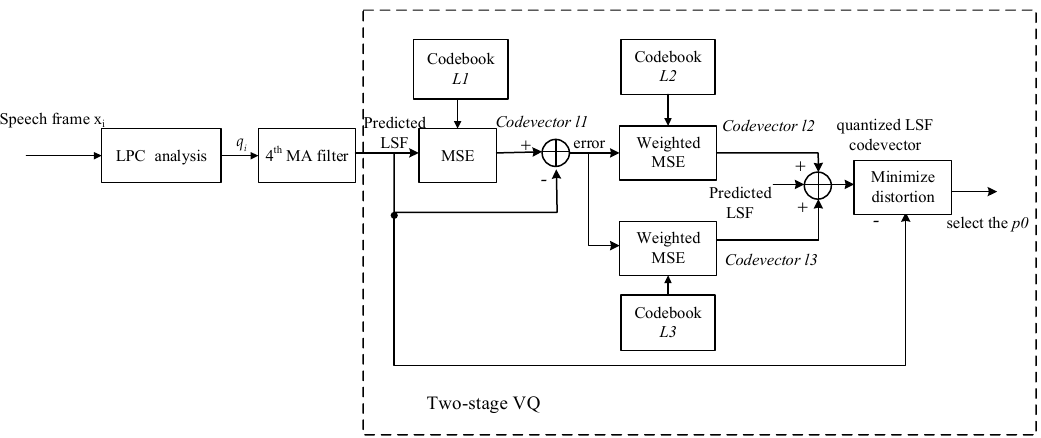
Figure 1. Structure of the two-stage vector quantization (VQ) for line spectrum frequency (LSF) coefficients.